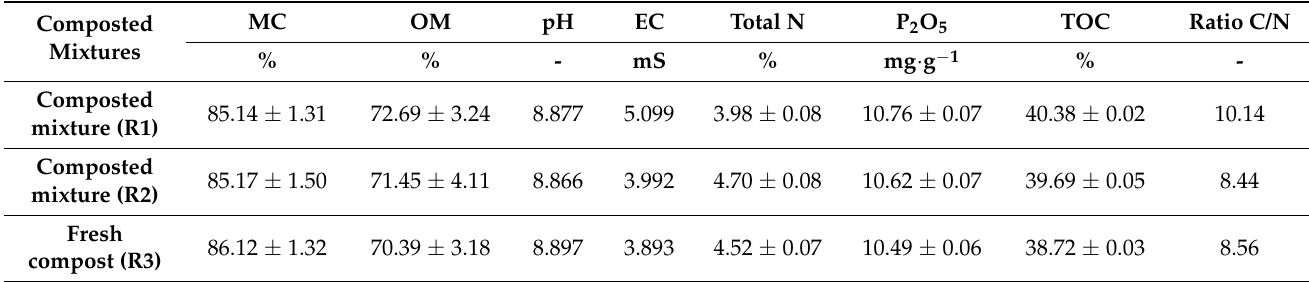
Table 4. Selected characteristics of the composted mixtures after 4 weeks (R1, R2) and 90 days (R3) of composting.